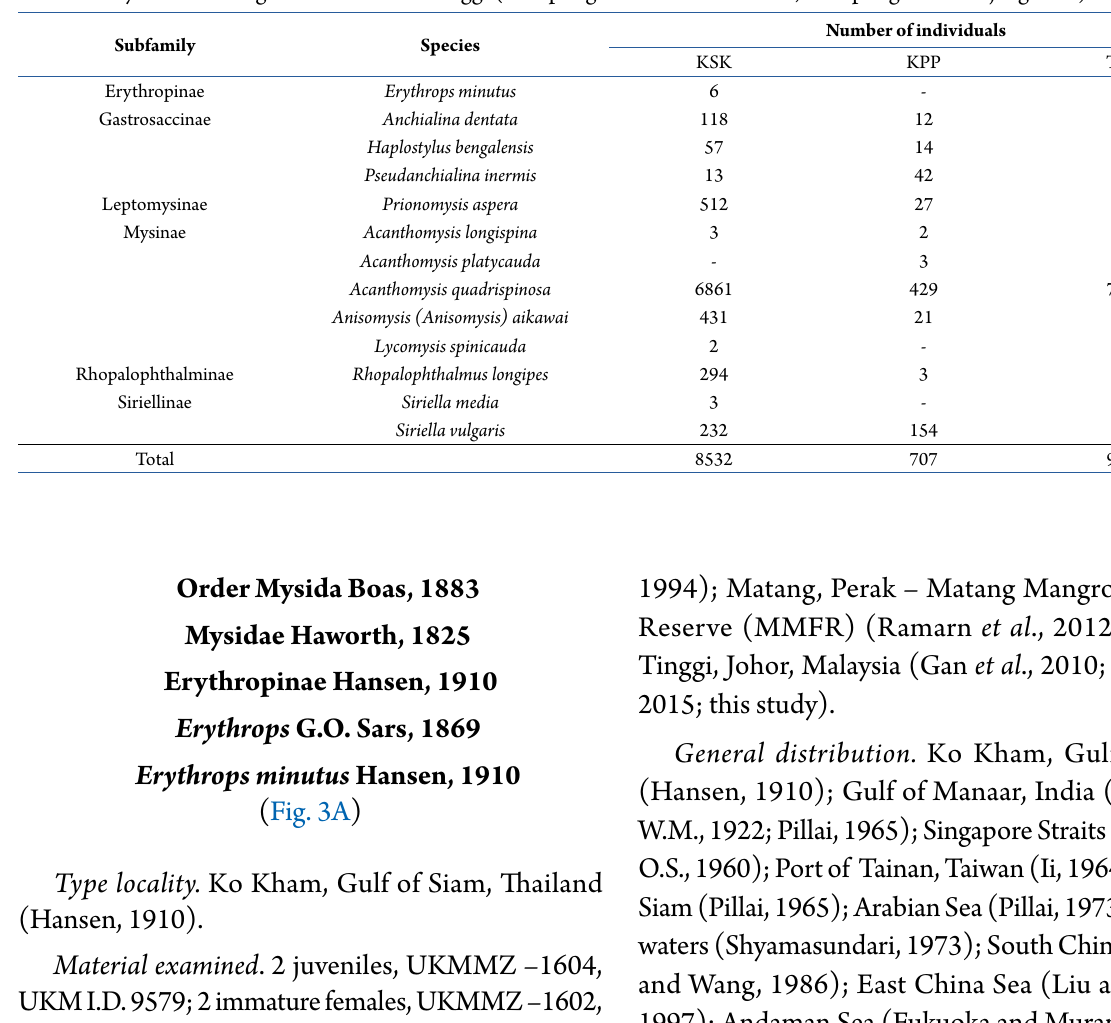
Table 2. Mysids from seagrass bed in Pulau Tinggi (Kampung Sebirah Kechil- KSK; Kampung Pasir Panjang-KPP). Subfamily Species Erythropinae Erythrops minutus Gastrosaccinae Anchialina dentata